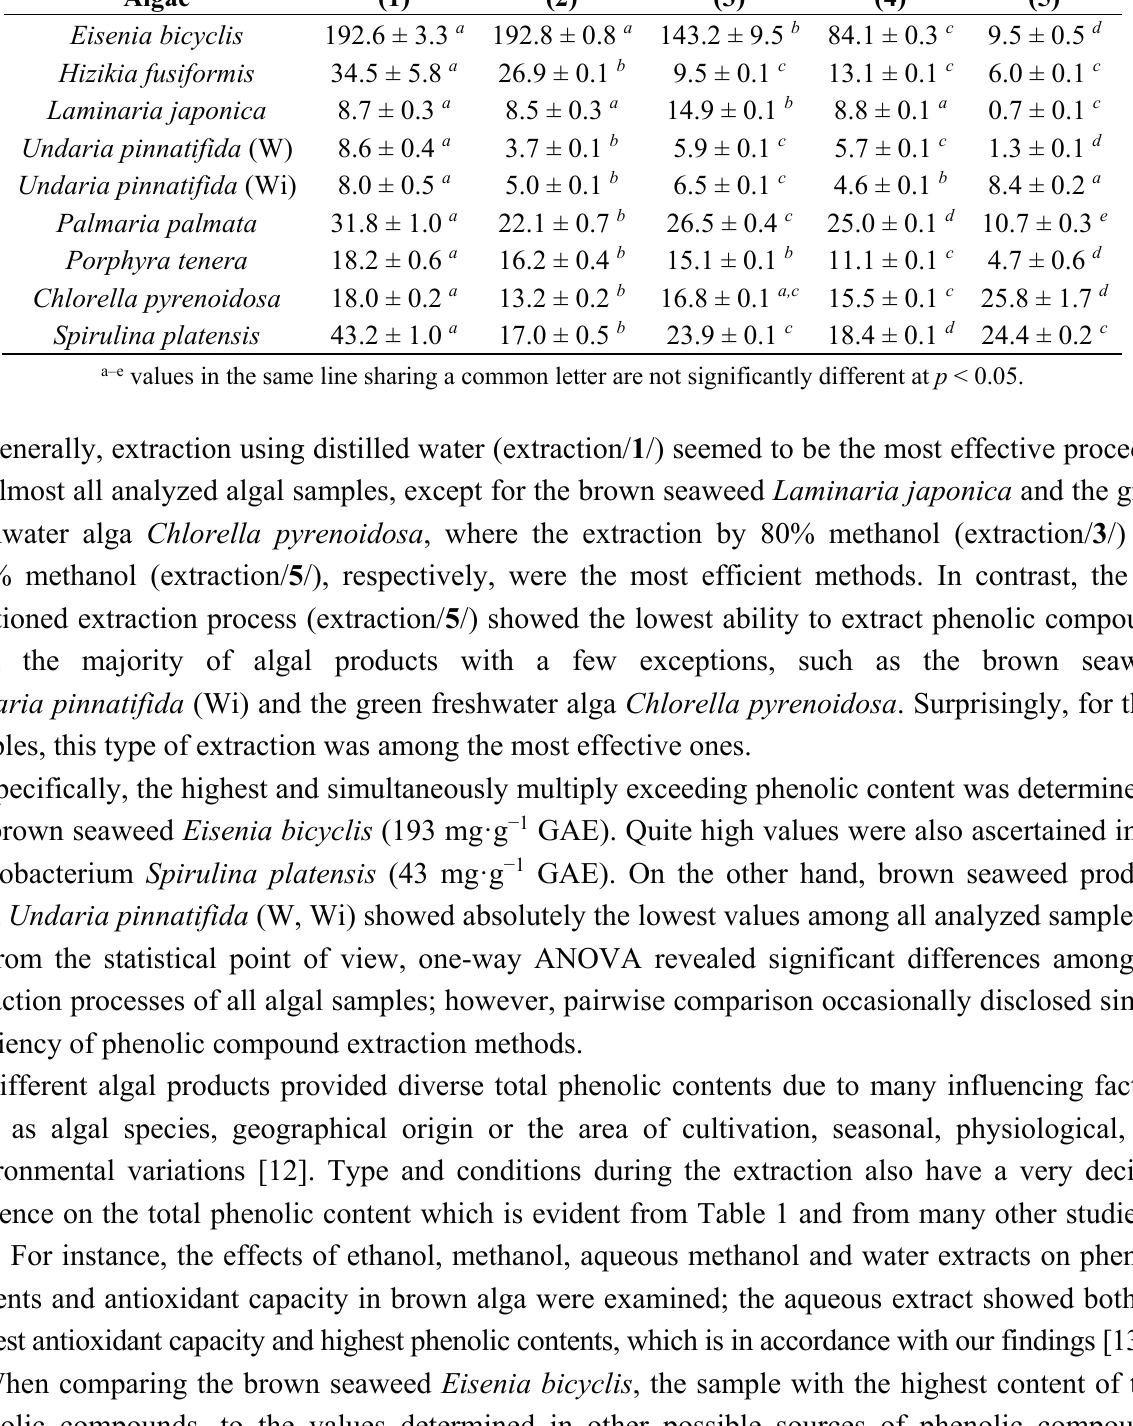
Table 1. Amounts (mg·g − 1 GAE) of total phenolic content of edible algal products after various extraction processes: (1)—extraction by distilled water (80 °C for 10 min in water bath with constant shaking); (2)—extraction by methanol-water-acetic acid (30:69:1, v/v/v) (70 °C for 50 min in water bath with constant shaking); (3)—extraction by 80% methanol (70 °C for 1 h in water bath with constant shaking); (4)—extraction by 70% acetone (30 °C for 30 min in water bath with constant shaking); (5)—extraction by 100% methanol (lab temperature ≈ 23 °C for 24 h, constant shaking). Results are shown as mean ± SD ( n = 4).